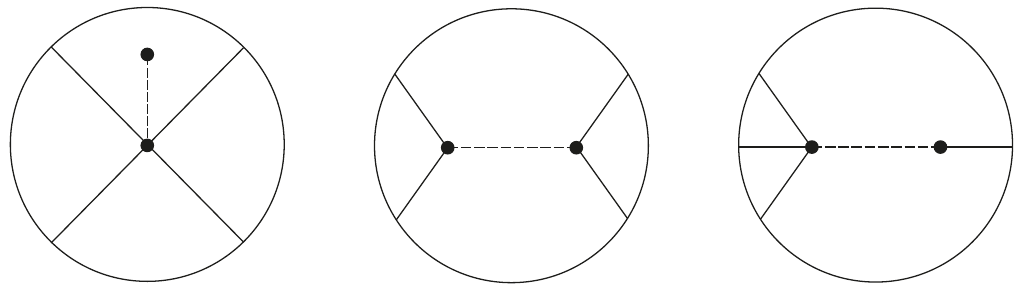
Figure 16 . Connected diagrams contributing to the two-point function. The combinatorics and the ± signs of the bulk-to-bulk propagator are not explicit.